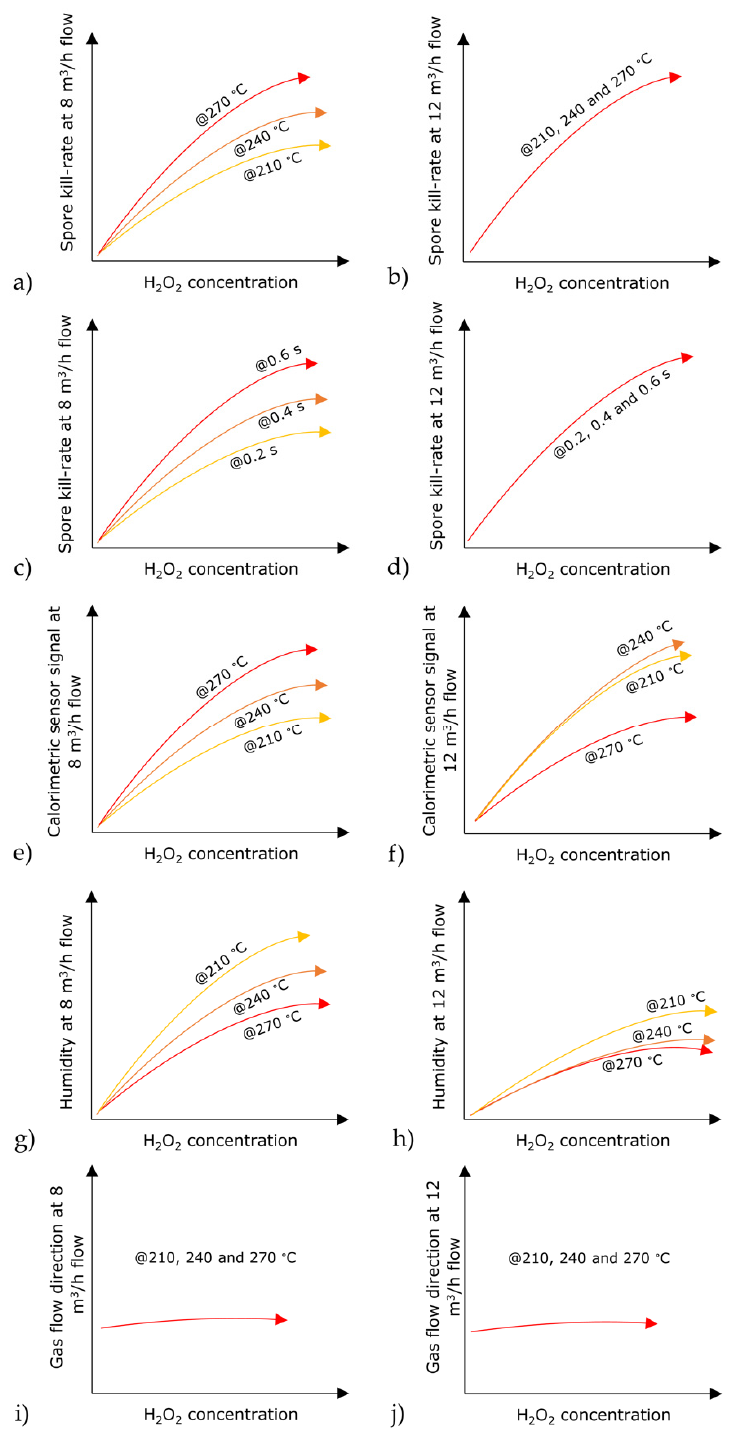
Figure 8. A schematic presentation of the correlations between the critical parameters during the sterilization process, detected by the multi-sensing platform, and the spore kill rates corresponding to the H 2 O 2 concentration during the sterilization process. ( a – d ) The kill rate of B. atrophaeus DSM 675 spores; ( e , f ) the detection of temperature changes by the calorimetric gas sensor; ( g , h ) the relative humidity; and ( i , j ) the H 2 O 2 gas flow direction under gas flow rates of 8 and 12 m 3 /h, respectively. To conclude, lower humidity, which results from a higher temperature and gas flow, is beneficial for a successful sterilization. Apart from the benefit of the lower humidity in